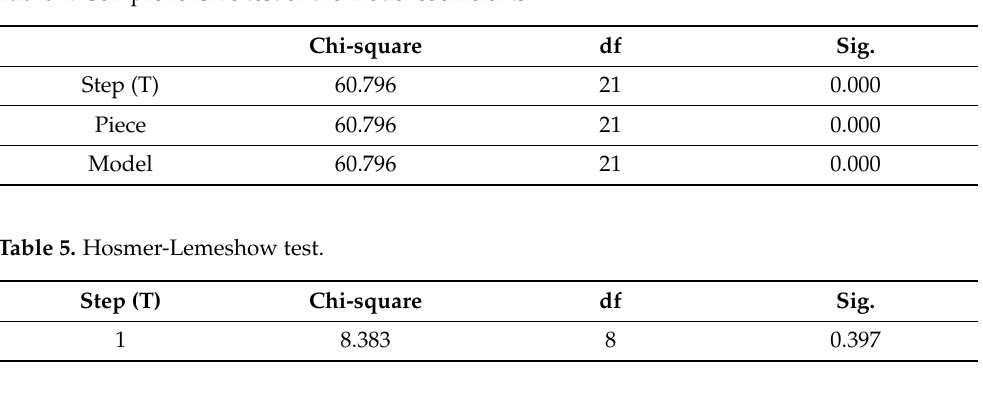
Table 4. Comprehensive test of the model coefficients.